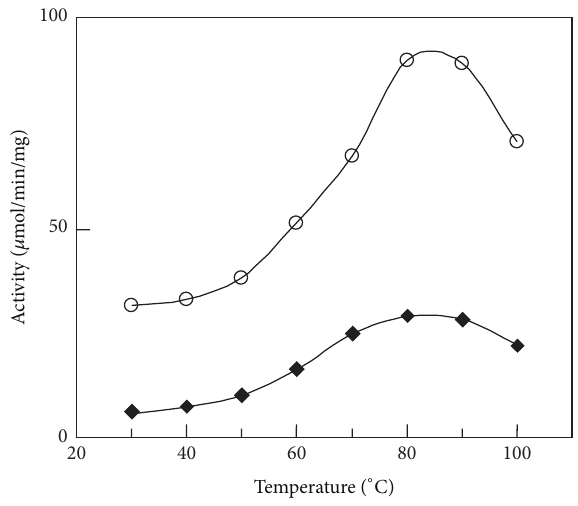
Figure 2: Temperature dependence of catalytic activity for ST1805- CS (open circle) and ST0587-CS (solid diamond), respectively.